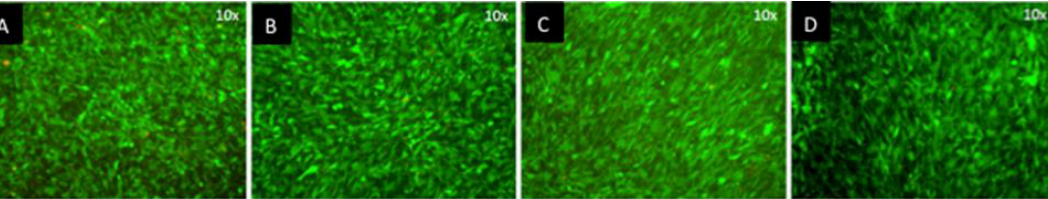
Figure 5. Cell viability is restored in PA-treated ePCL scaffolds by ethanol wash and is not affected by concentration of PAA. Live/Dead staining of MC3T3 on scaffolds with no exposure to PAA ( A ), 1000 ppm ( B ), 2500 ppm ( C ) and 5000 ppm ( D ). It can be readily seen that the cell attachment and survival in PAA treated scaffolds is comparable to controls.